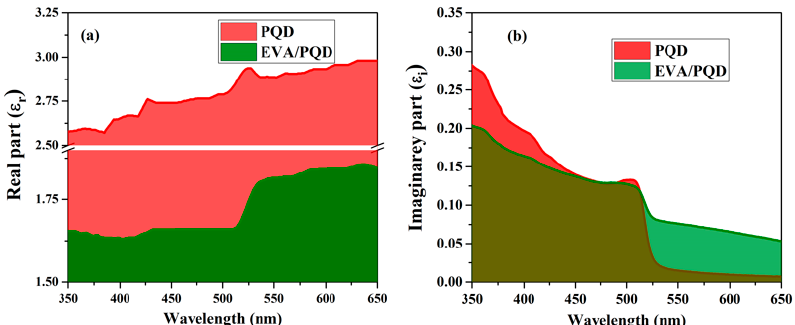
Figure 8. ( a ) Real and ( b ) imaginary parts of the complex dielectric constant of the pure PQD and the EVA-TPR/PQD films.